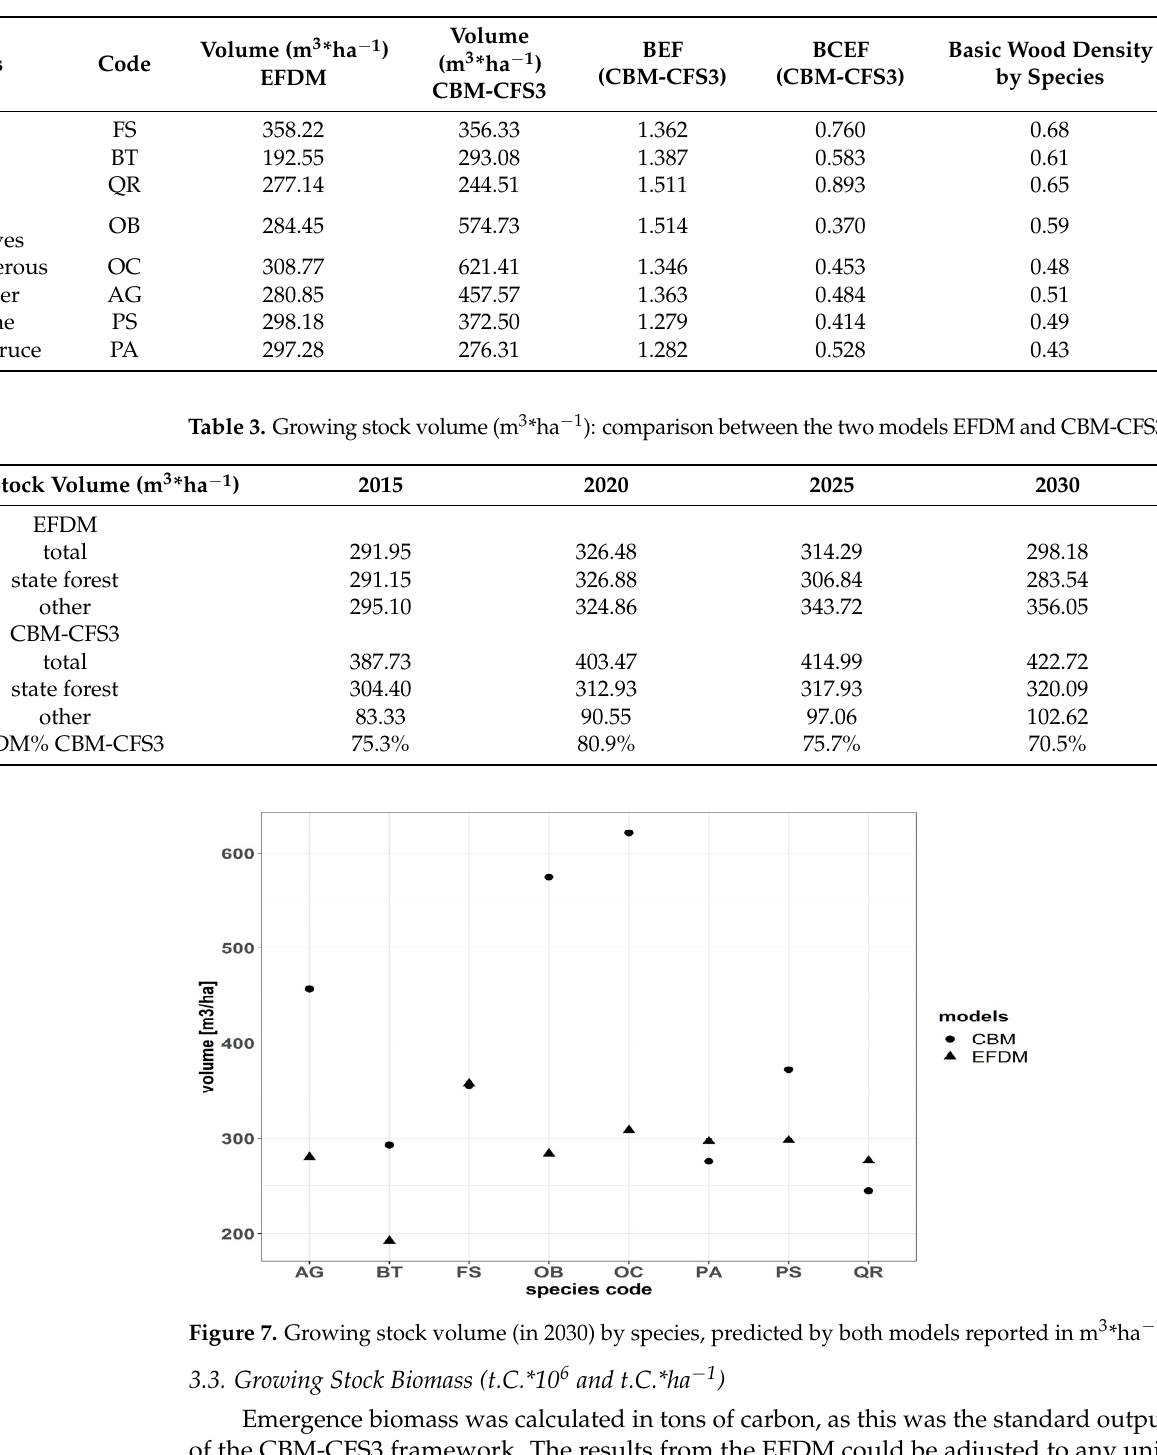
Table 4. Comparison of levels of growing stock biomass (t.C*10 6 ). Growing Stock Biomass (t.C*10 6 )